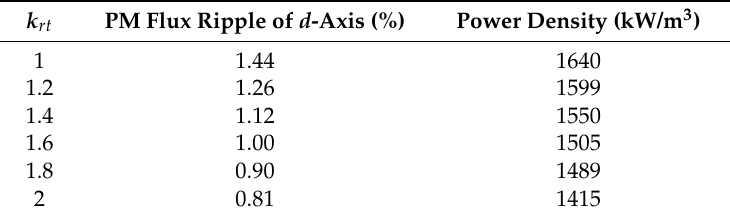
Table 1. PM flux pulsations of the d -axis of the inner FSPM machine and the power density of the